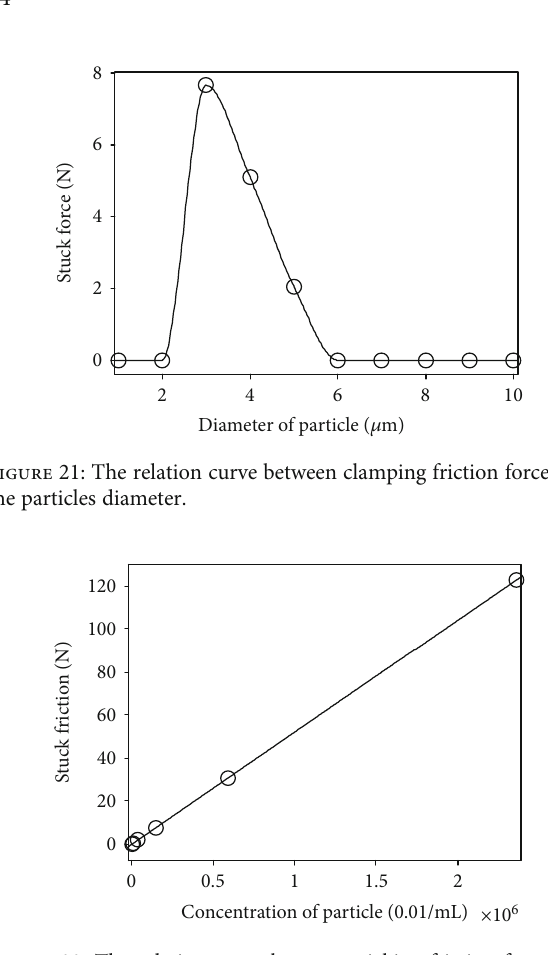
Figure 22: The relation curve between sticking friction force and the particle concentration.